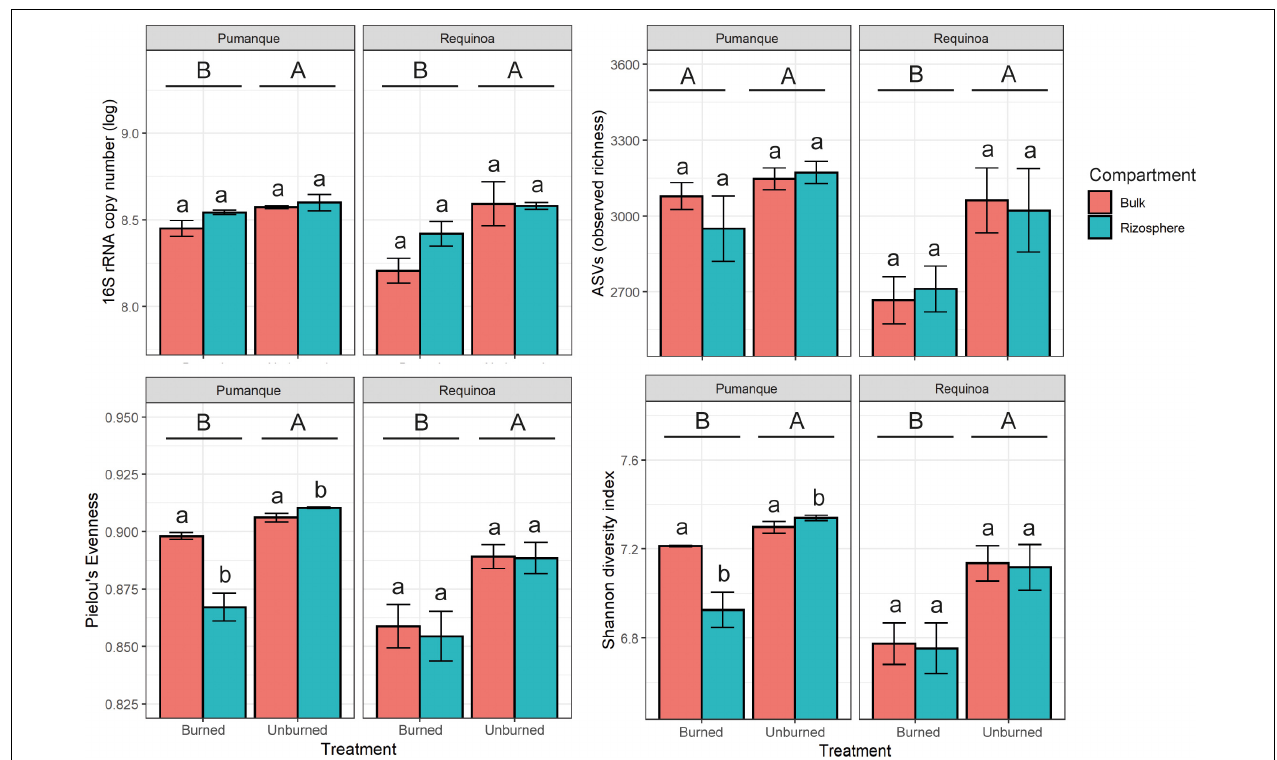
FIGURE 4 | Bar plots of abundance (mean ± SE, n = 3) and alpha diversity (mean ± SE, n = 3) of prokaryotic communities for each study locations showing effect of treatment (burned vs. unburned) and soil compartment (bulk soil vs. rhizosphere soil). Different uppercase letters show significant ( p < 0.05) differences by treatment. Different lowercase letters show significant ( p < 0.05) differences by compartment. Interactions between treatment and compartment were not significant ( p <